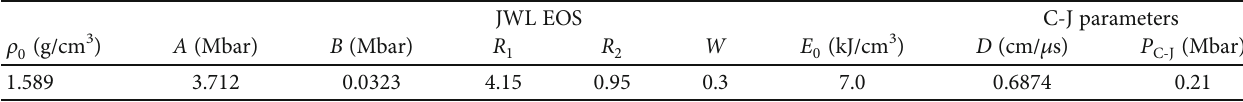
Table 1: The parameters for TNT explosive.